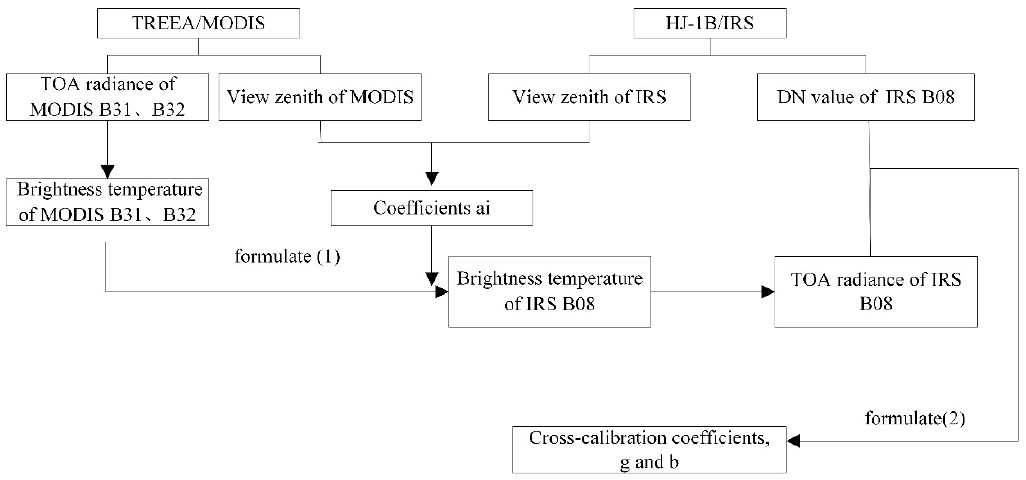
Figure 5. Flow chart of cross-calibration by twin-channel difference model.